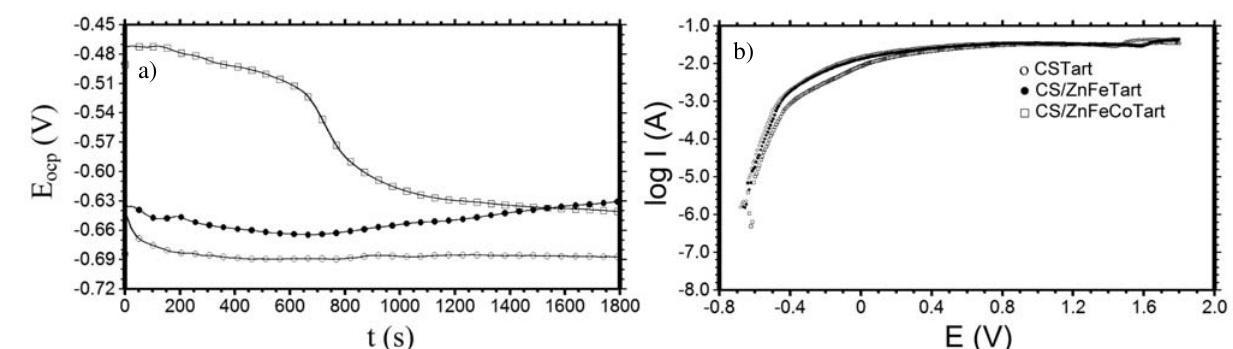
Fig. 11. The E -t diagrams immediately after of immersion time (a) and the anodic polarization curves after 168 h of exposure time (b) obtained ocp for electrodes, in 3.5% NaCl